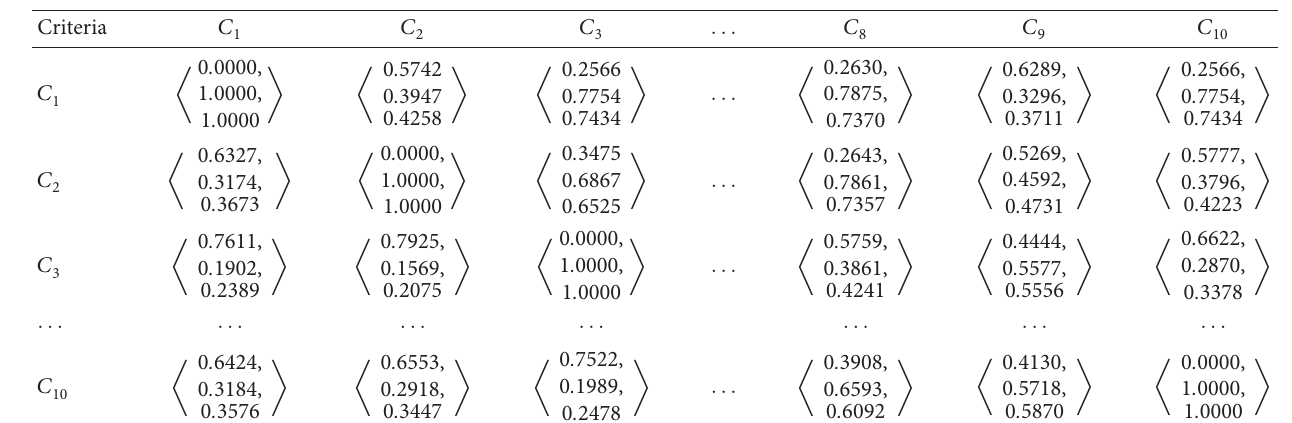
Table 6: Aggregated